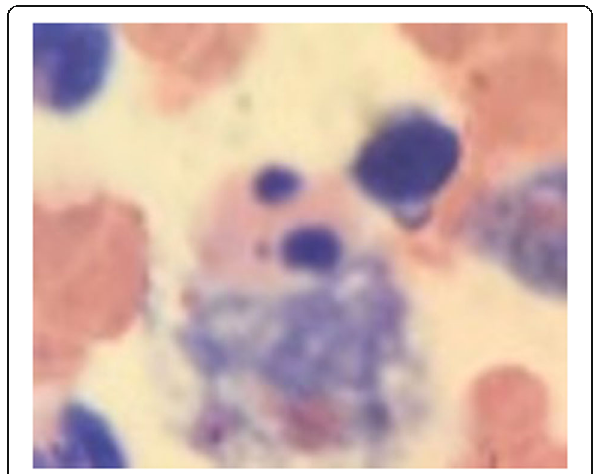
Fig. 1 Hemophagocytic cells detected in bone marrow aspirate